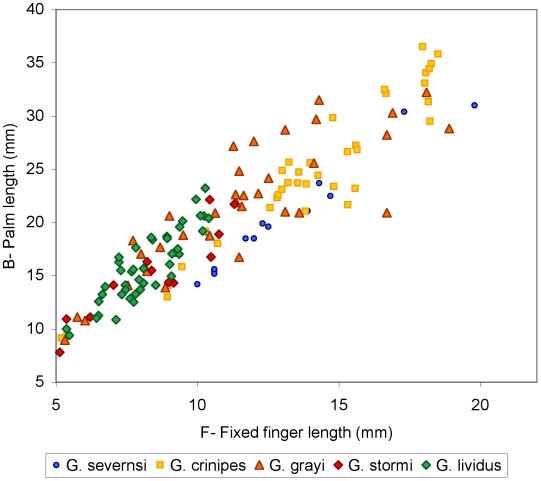
Palm length (B) vs. fixed finger length (F) in mm.